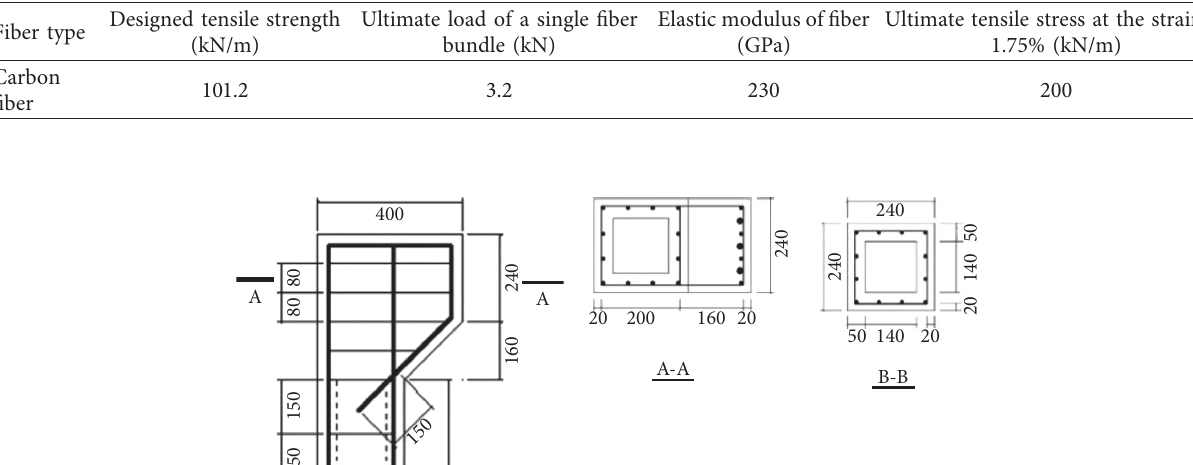
Table 2: Physical properties of